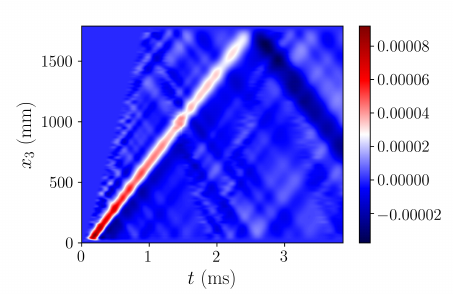
Figure 3: The space-time evolution of particle velocity in the transverse ( z ) direction for σ (cid:48) 0 . 6322. The color code indicates the velocity component (m / s) in the transverse